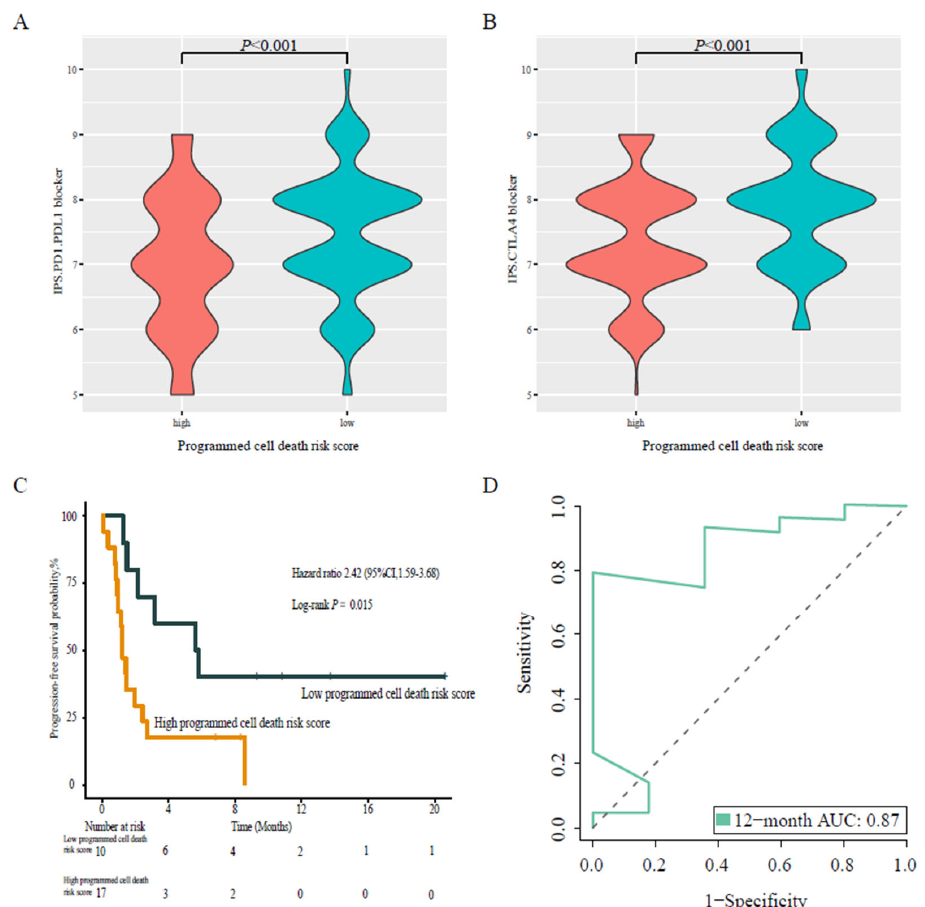
Figure 6. Validation of the programmed cell death risk score in the immunotherapy cohort. ( A ) Violin plots showing the difference of PD-1/PD-L1 IPS between the high and low programmed cell death risk score groups. ( B ) Violin plots showing the difference of CTLA4 IPS between the high and low programmed cell death risk score groups. ( C ) Kaplan–Meier survival curve of non-small cell lung cancer patients who were treated with anti-PD-1/PD-L1. ( D ) ROC analysis showing the immunotherapy prognostic performance of the programmed cell death risk score formula.